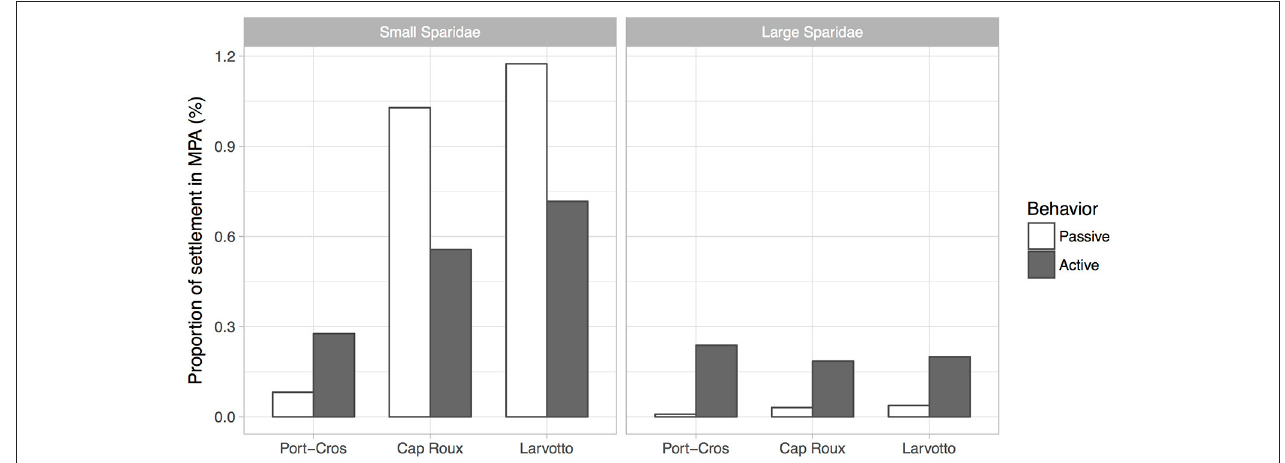
FIGURE 4 | Proportion of virtual larvae that successfully reached a coastal habitat within an MPA during their competency